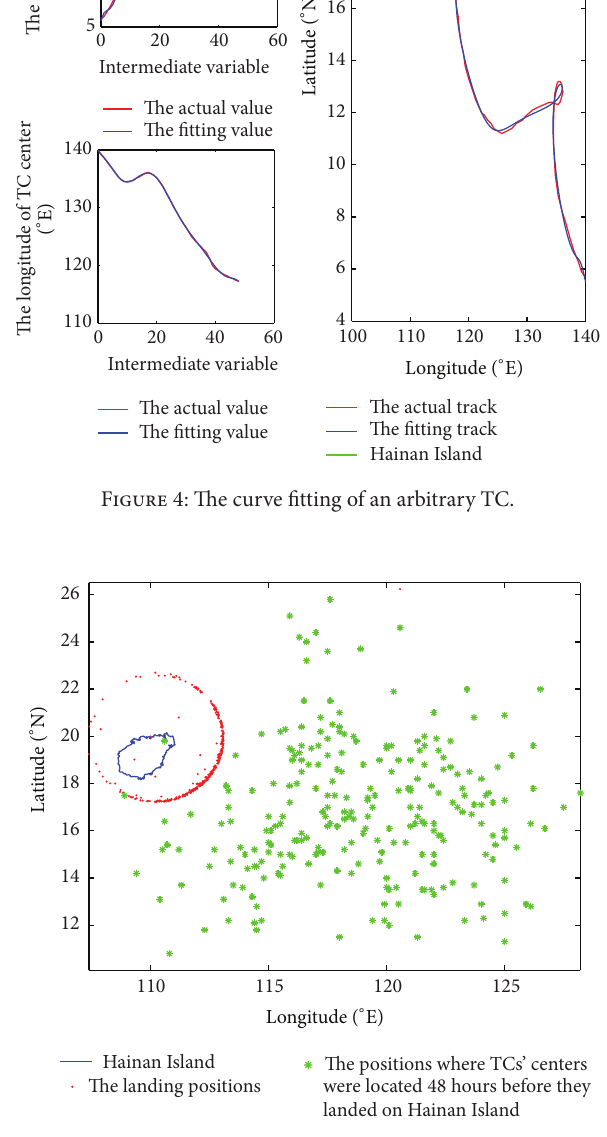
Figure 5: The region selected as research